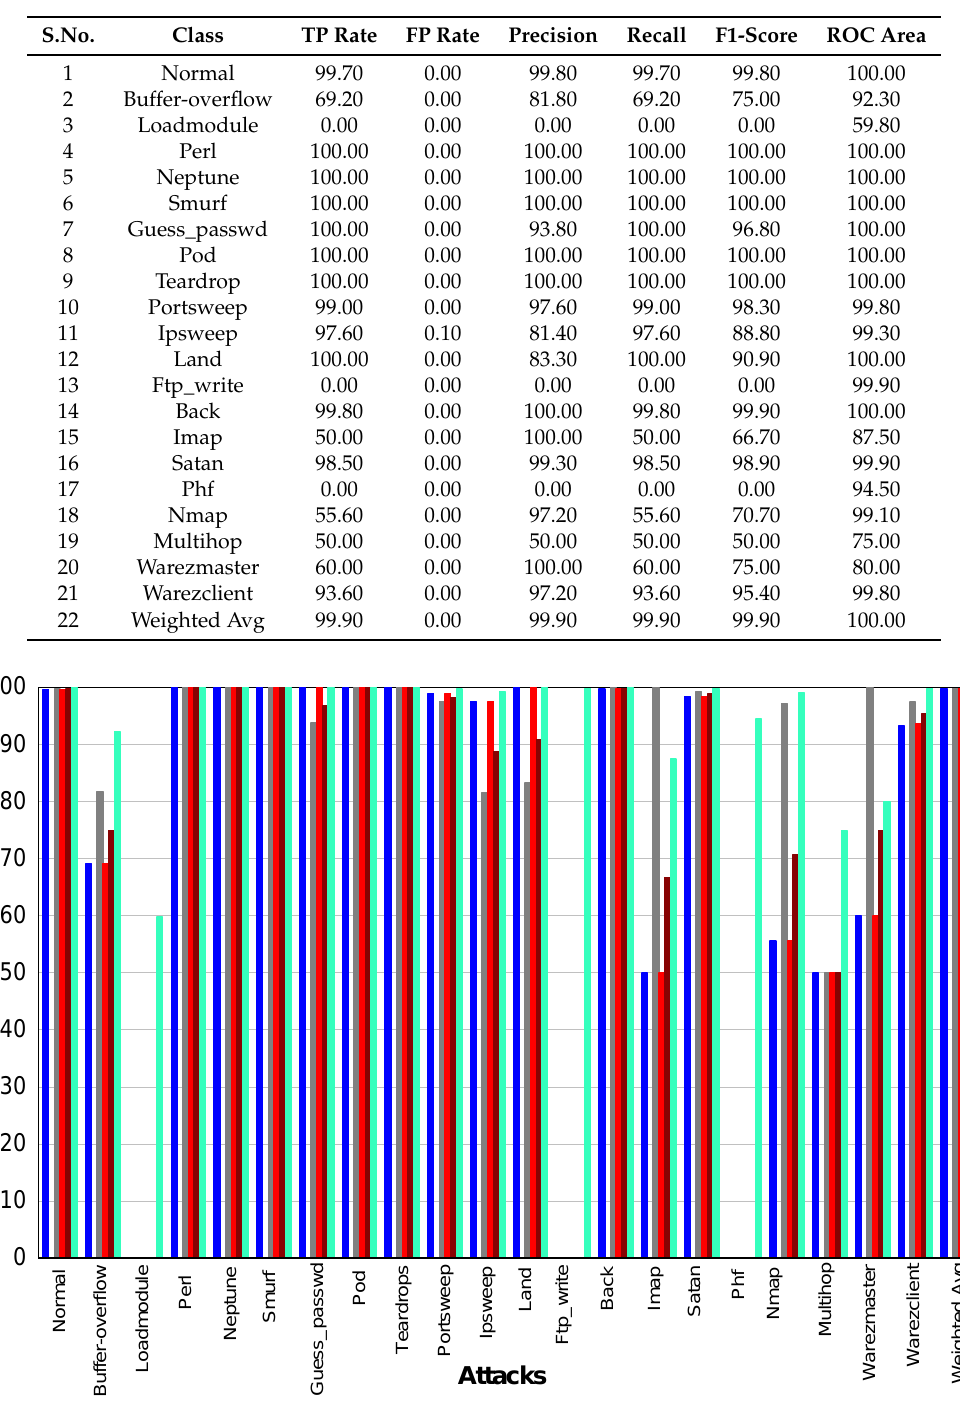
Table 26. Multiclass classification report for KDD99 using Bagging Reptree.